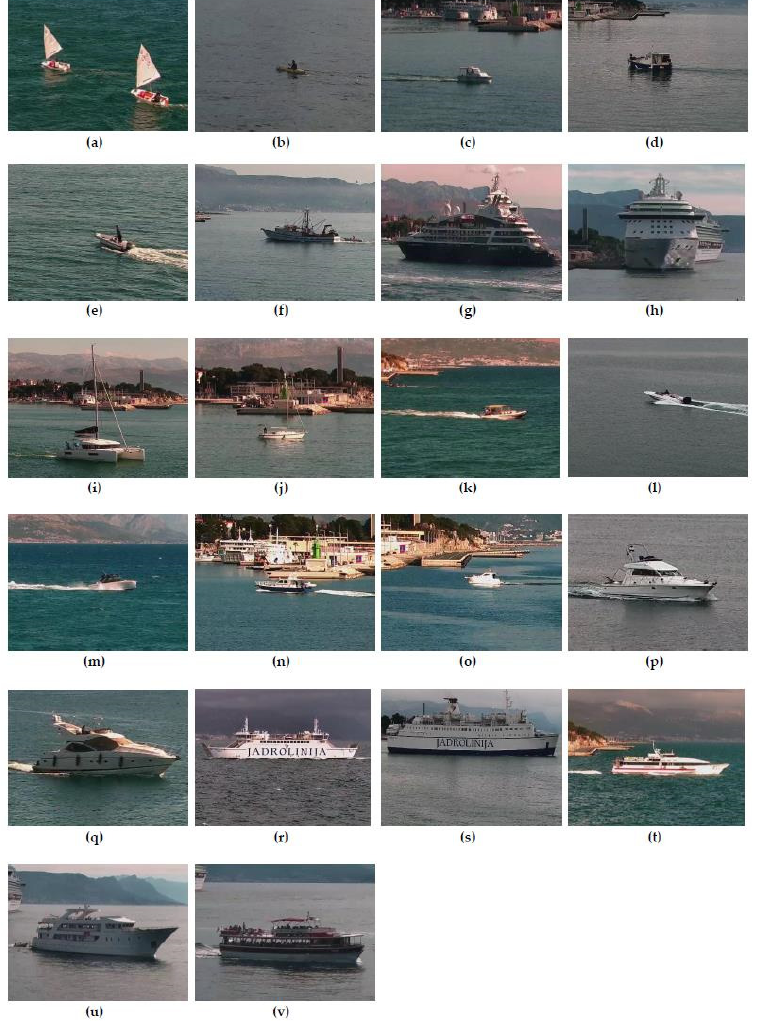
Figure A1. ( a , b ) are small craft boats; ( c – e ) are small fishing boats; ( f ) are fishing trawlers; ( g , h ) are large passenger ships; ( i , j ) are sailing boats; ( k – m ) are speed crafts; ( n , o ) are motorboats; ( p , q ) are pleasure yachts; ( r ) is a medium ferry; ( s ) is a large ferry; ( t ) is a high-speed craft; and finally, ( u , v ) are small passenger ships.